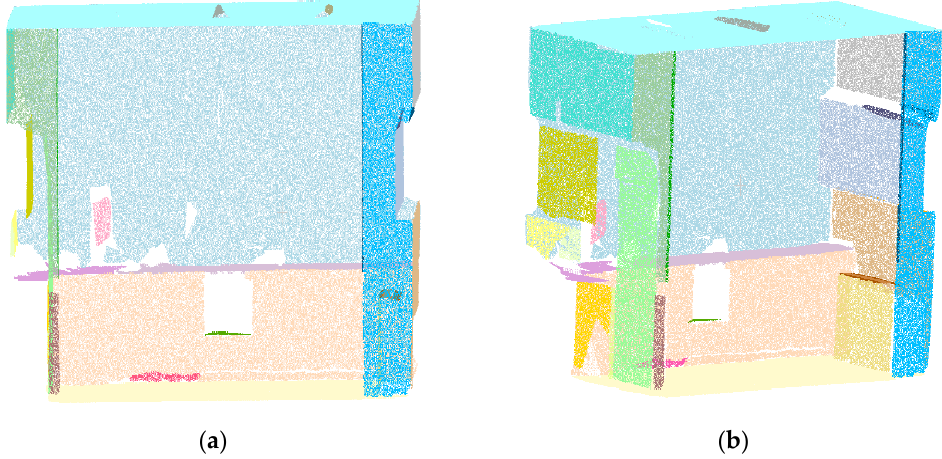
Figure 14. Pantry’s segmentation results using the RANSAC ‐ RG method: ( a ) front view and ( b ) side view.